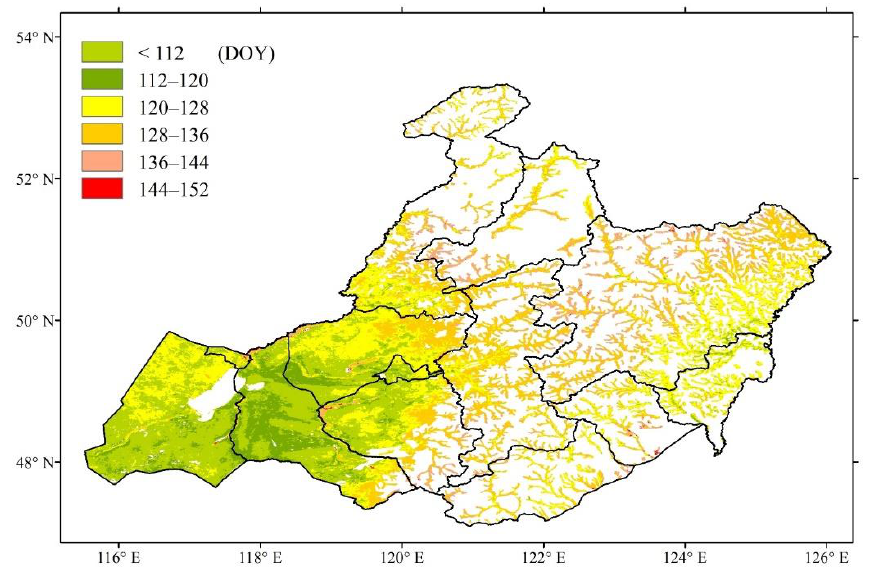
Figure 6. Mean green-up dates between 2001 and